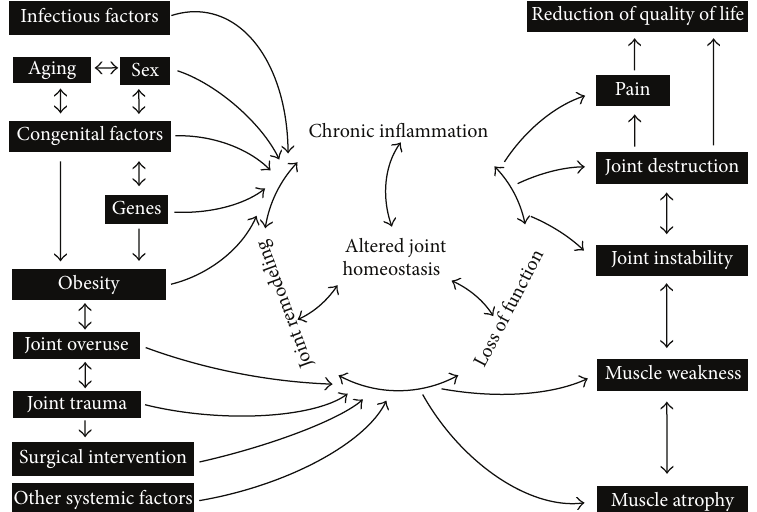
Figure 1: Schematic of a closed disease circle comprising the disease progression of osteoarthritis taking into account its causes and